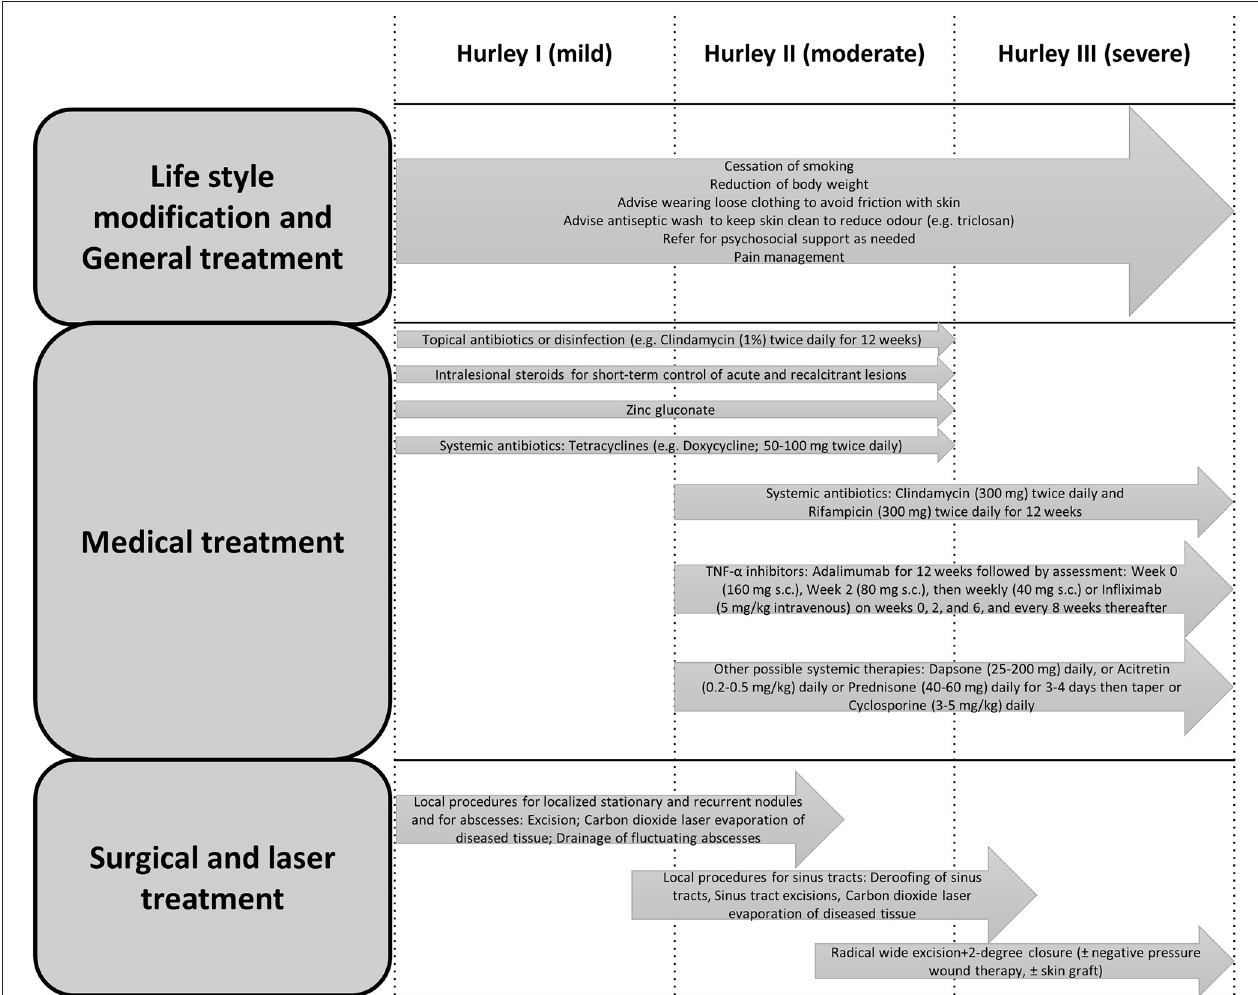
FIGURE 1 | Clinical practice recommendations for the treatment of HS, modified from Hunger et al. and Saunte and Jemec (15, 31).